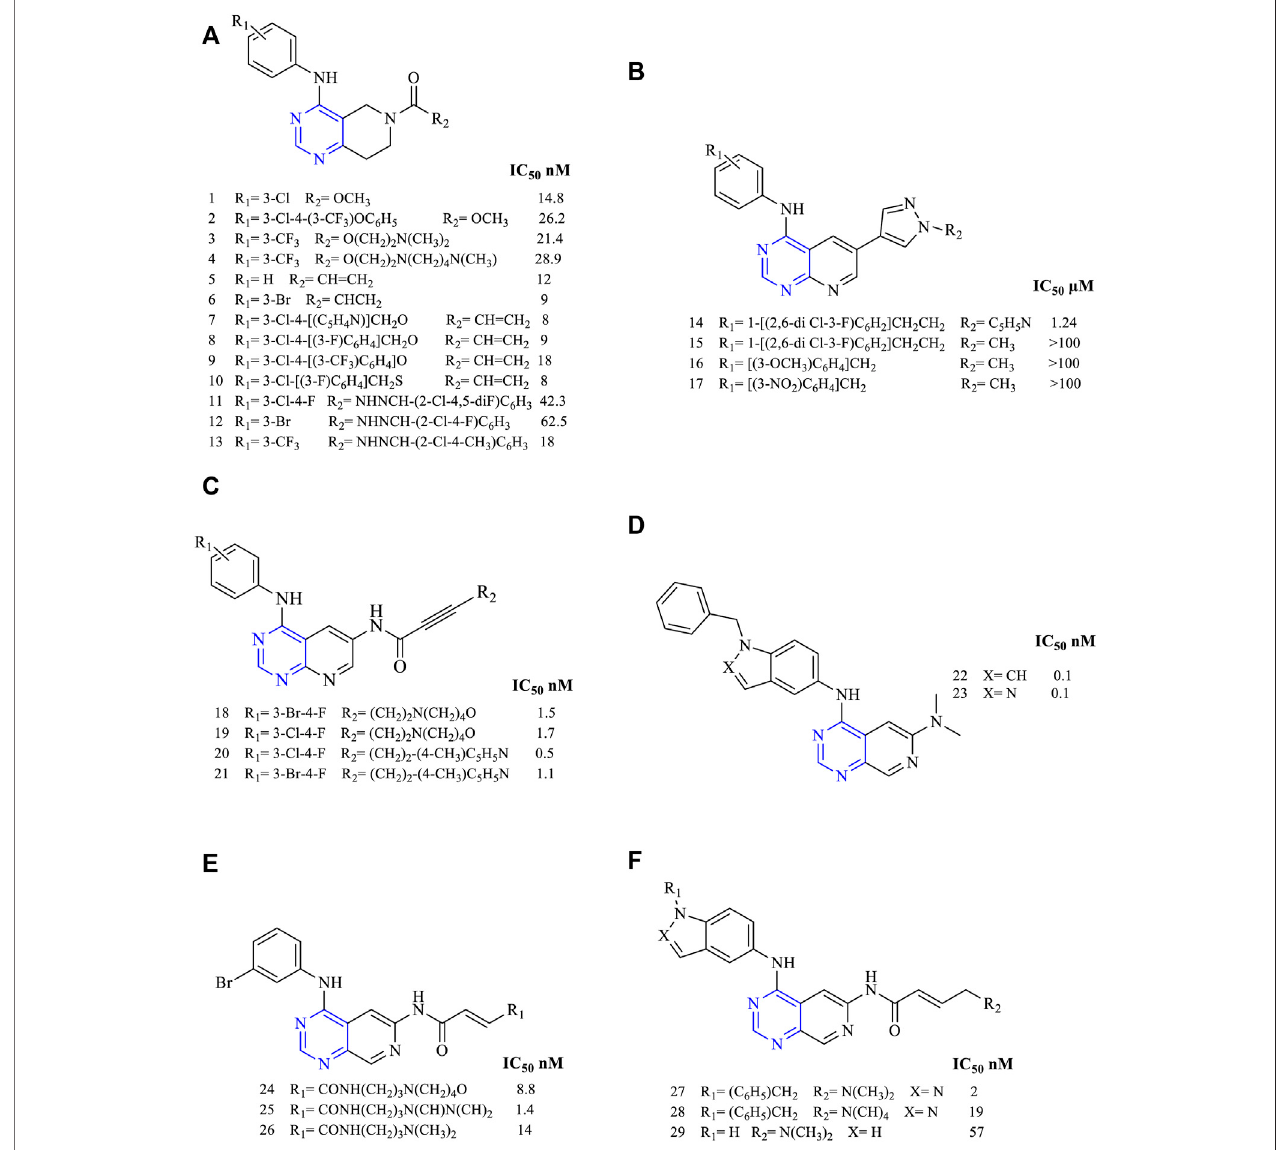
FIGURE 4 | Chemical structure of (A) 4-anilino-7,8-dihydropyrido [4,3- d ]pyrimidine, (B) 4,6- disubstituted [2,3- d ]pyrimidine, (C) 4,6- disubstituted [2,3- d ] pyrimidine, (D) 4,6- disubstituted pyrido [3,4- d ]pyrimidine, (E) 4-anilinopyrido [3,4- d ]pyrimidino-6-acrylamide, and (F) 4-fused anilinopyrido [3,4- d ]pyrimidino-6-